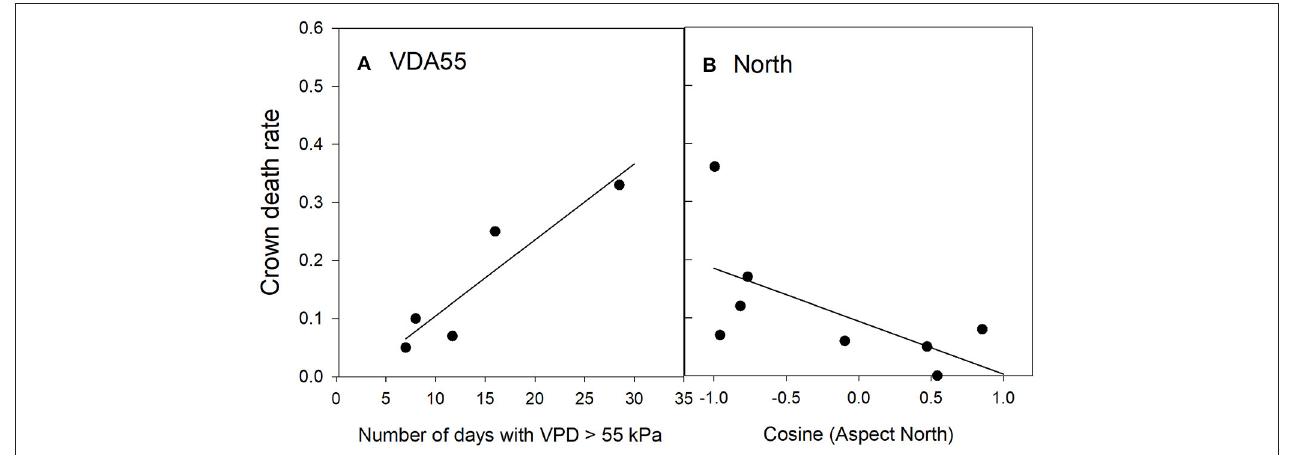
FIGURE 5 | Relationships between Texas persimmon crown death rate and significant risk factors in the top regression model (P1). The values of the risk factors were divided into classes of the number of days with aa VPD > 55 kPa (A) and the Cosine of the Aspect North (B) . Data were binned into 5 (VDA55) or 8 (North) classes with approximately equal membership and the class average was plotted on the x-axis. The number of classes were the largest permitted by the granularity of the data. See Table 2 for an explanation of variable names.